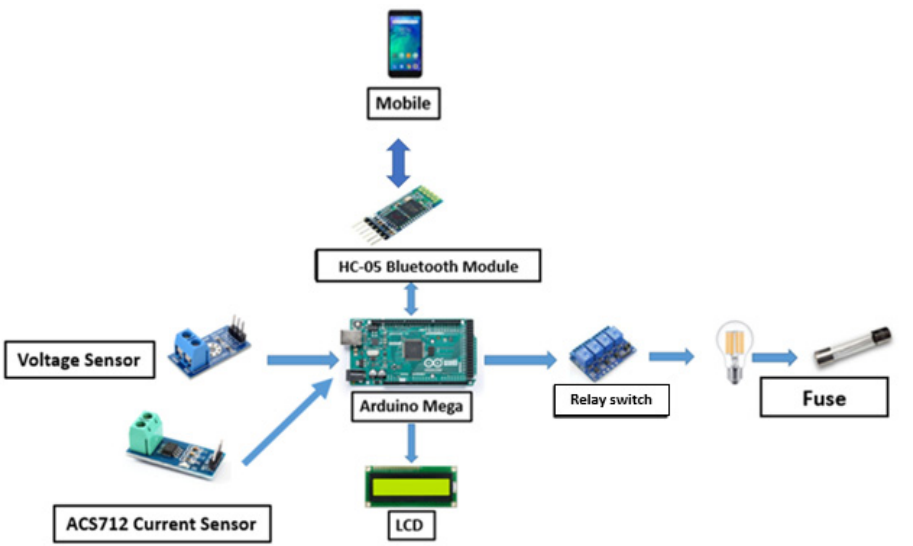
Figure 3. Schematic view of a smart distribution system.